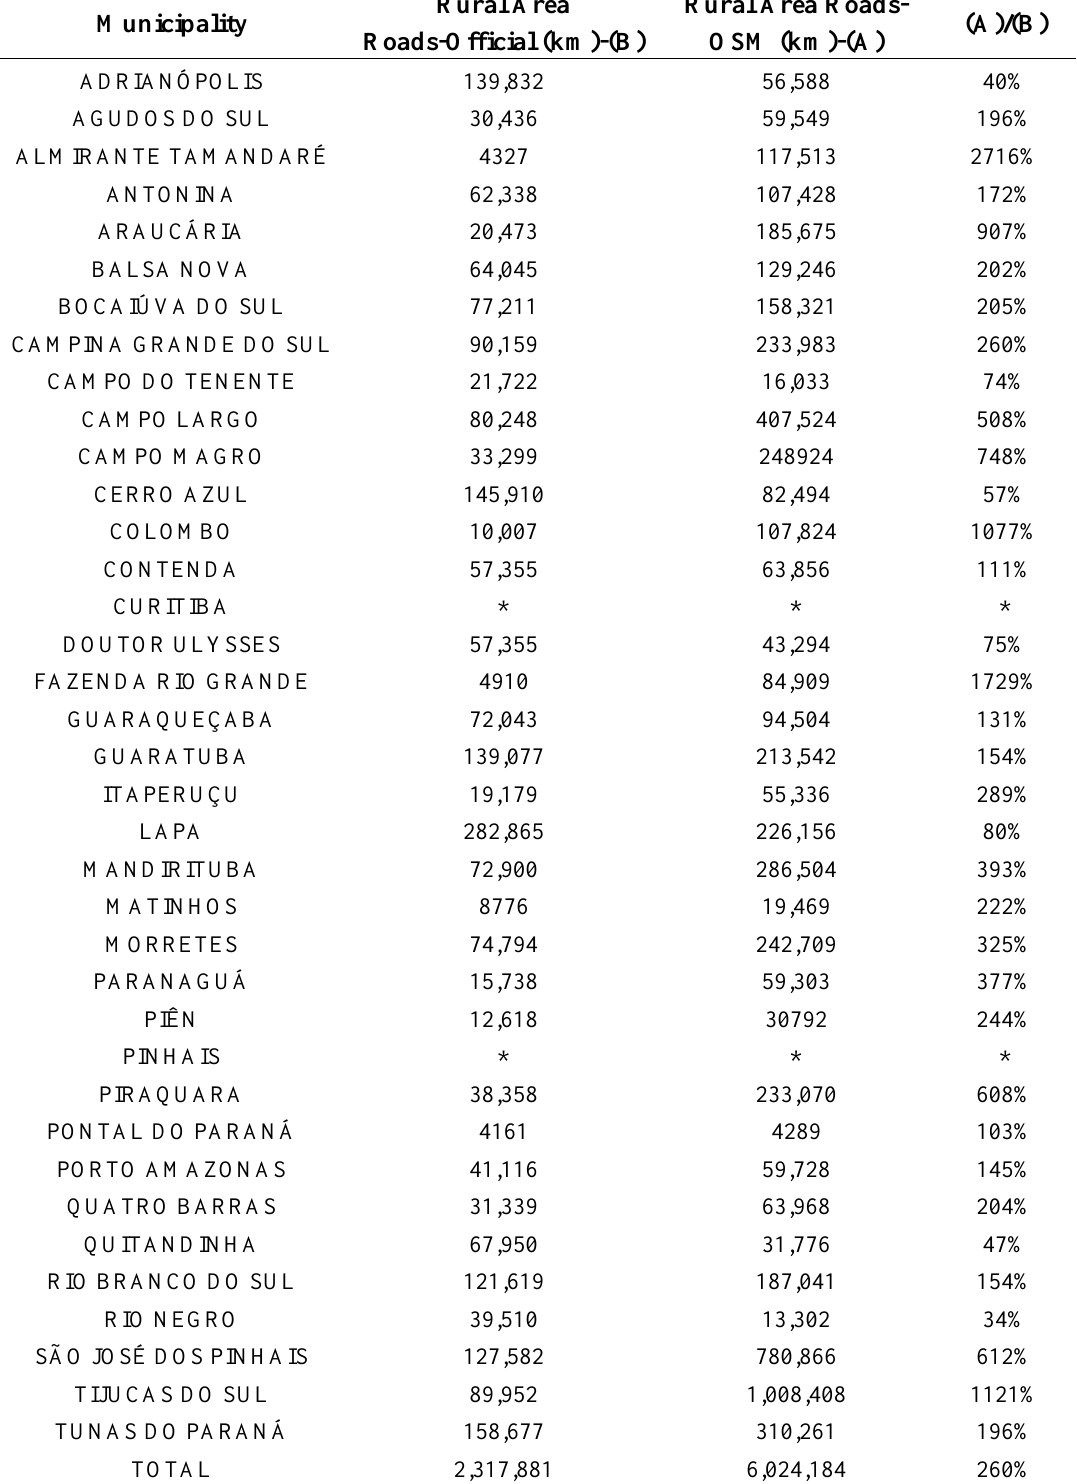
Table 3. Total length of roads in rural areas by municipality. Rural Municipality